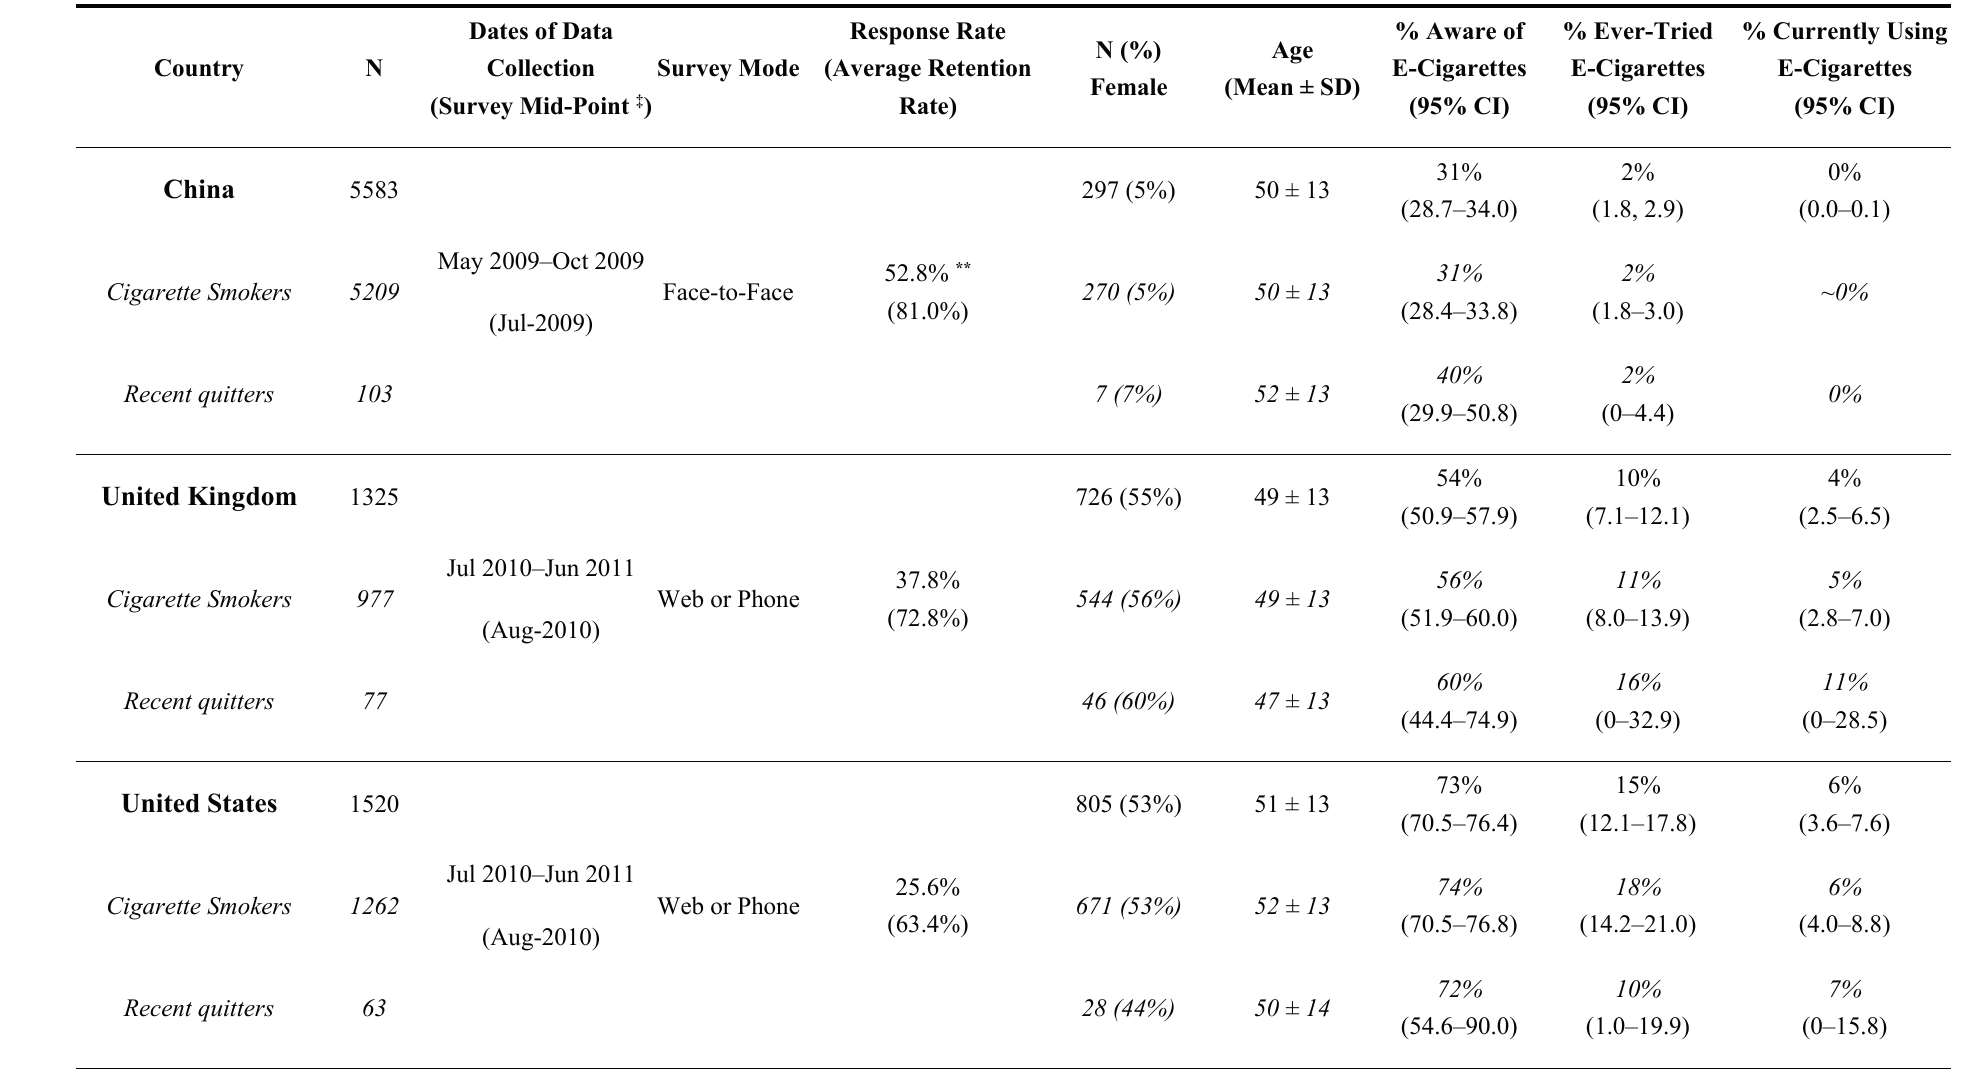
Table 1. Sociodemographic and Smoking Characteristics and Patterns of E-Cigarette